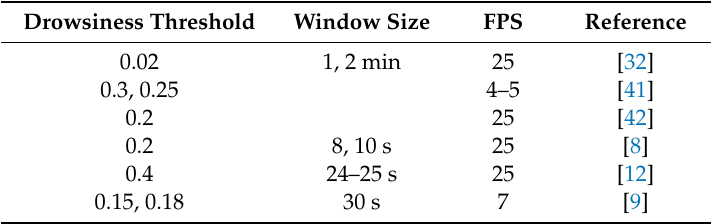
Table 1. Drowsiness thresholds reported in the literature for percentage of eyelid closure